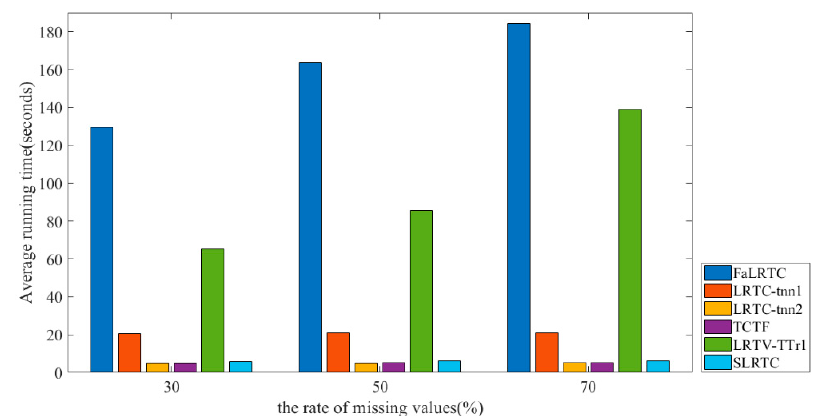
image; ( c ) FaLRTC (29.09 dB); ( d ) TCTF (26.94 dB); ( e ) LRTC-TNN1 (28.94 dB); ( f ) LRTC-TNN2 (29.14